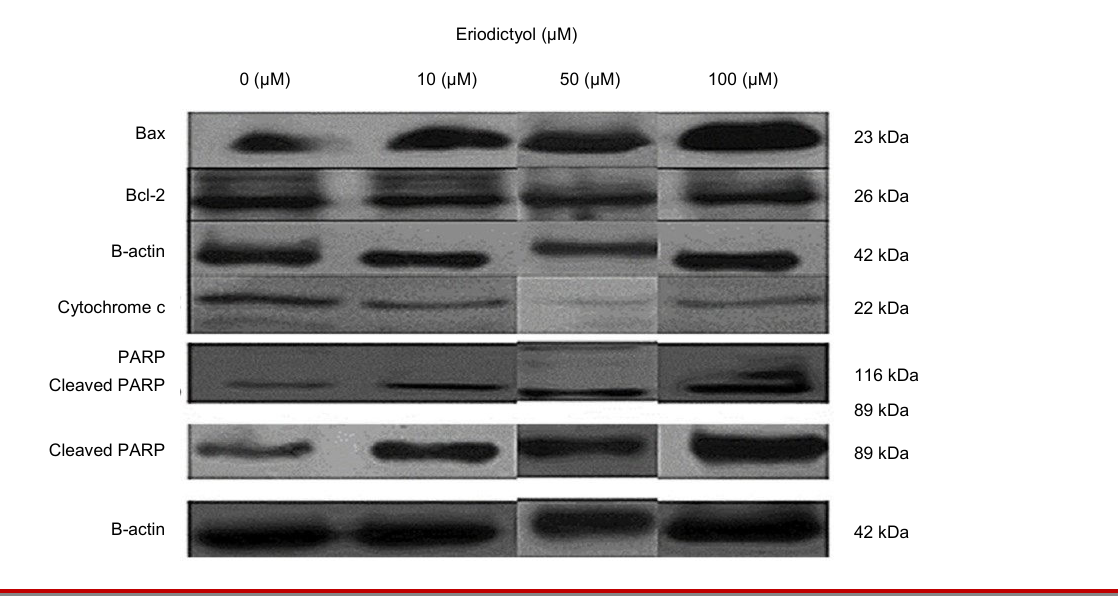
Figure 7 : Effect of eriodictyol on the expression levels of various apoptosis-related proteins in Hep-G2 liver cancer cells. The expression levels of these proteins were detected by Western blot followed by treatment of cells with 0, 10, 50 and 100 µM eri- odictyol for 48